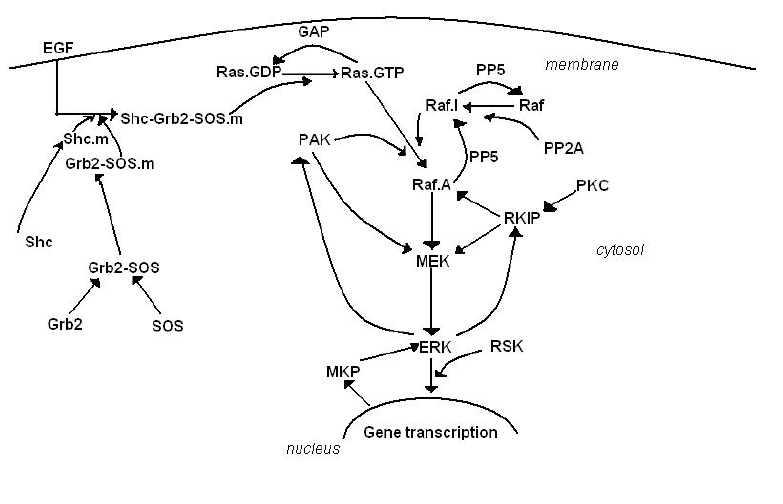
Figure 1: Simple representation of the structure of MAPK/ERK